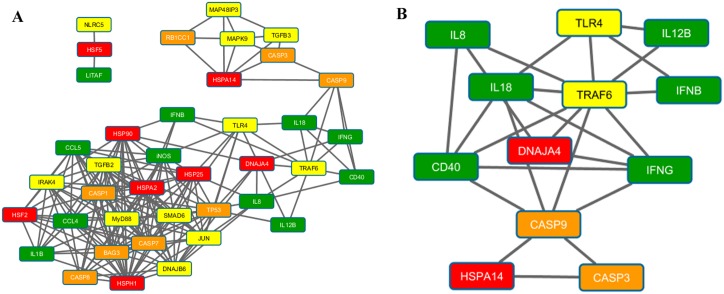
Spearman correlation network for samples treated with LPS and heat stress samples at time point 2h.(A) The complete network showing interaction between genes at 0 hours after LPS under heat stress treatment. Highly connected hubs includes CASP9, IL18, IFNB, IL8, and iNOS. There appears to be a small cluster of genes related to apoptotic pathway formed near the top of the network. (B) Cluster 2 from MCODE network clustering algorithm showing the interaction between IL8, IL18, TLR4, TRAF6, CD40, IFNB, IFNG, and CASP9. The cluster shows interaction between multiple mechanisms during response to LPS stimulation under heat stress. Interesting to note once again the additional interaction with the CASP9/CASP3 apoptotic pathway.